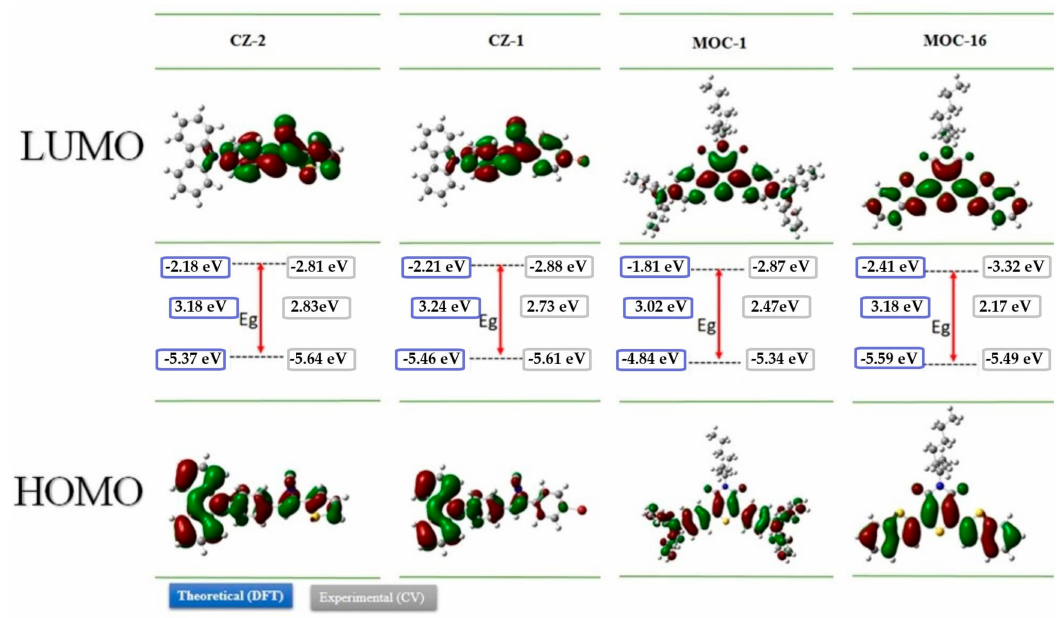
Figure 1. The optimized geometries and electron-state-density distributions and HOMO-LUMO energy levels of CZ-2, CZ-1, MOC-1 and MOC-16 using density functional theory (DFT) at the B3LYP/6-31G* and cyclic voltammetry (CV)